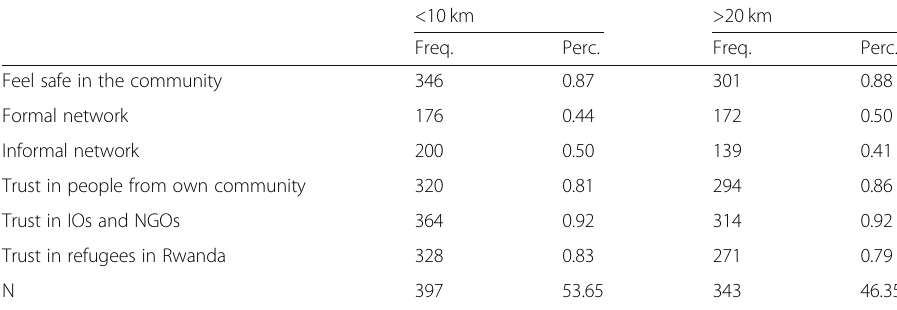
Table 3 Descriptive differences in outcome variables, by distance from a refugee camp <10 km >20 km Freq. Perc. Freq. Perc.